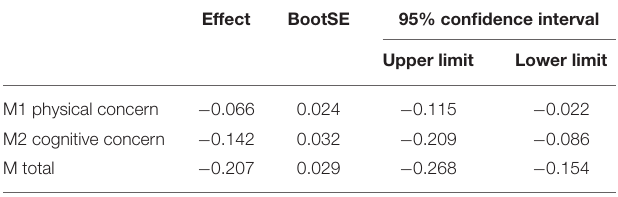
TABLE 4 | Bootstrap analysis of mediation effect significance test.